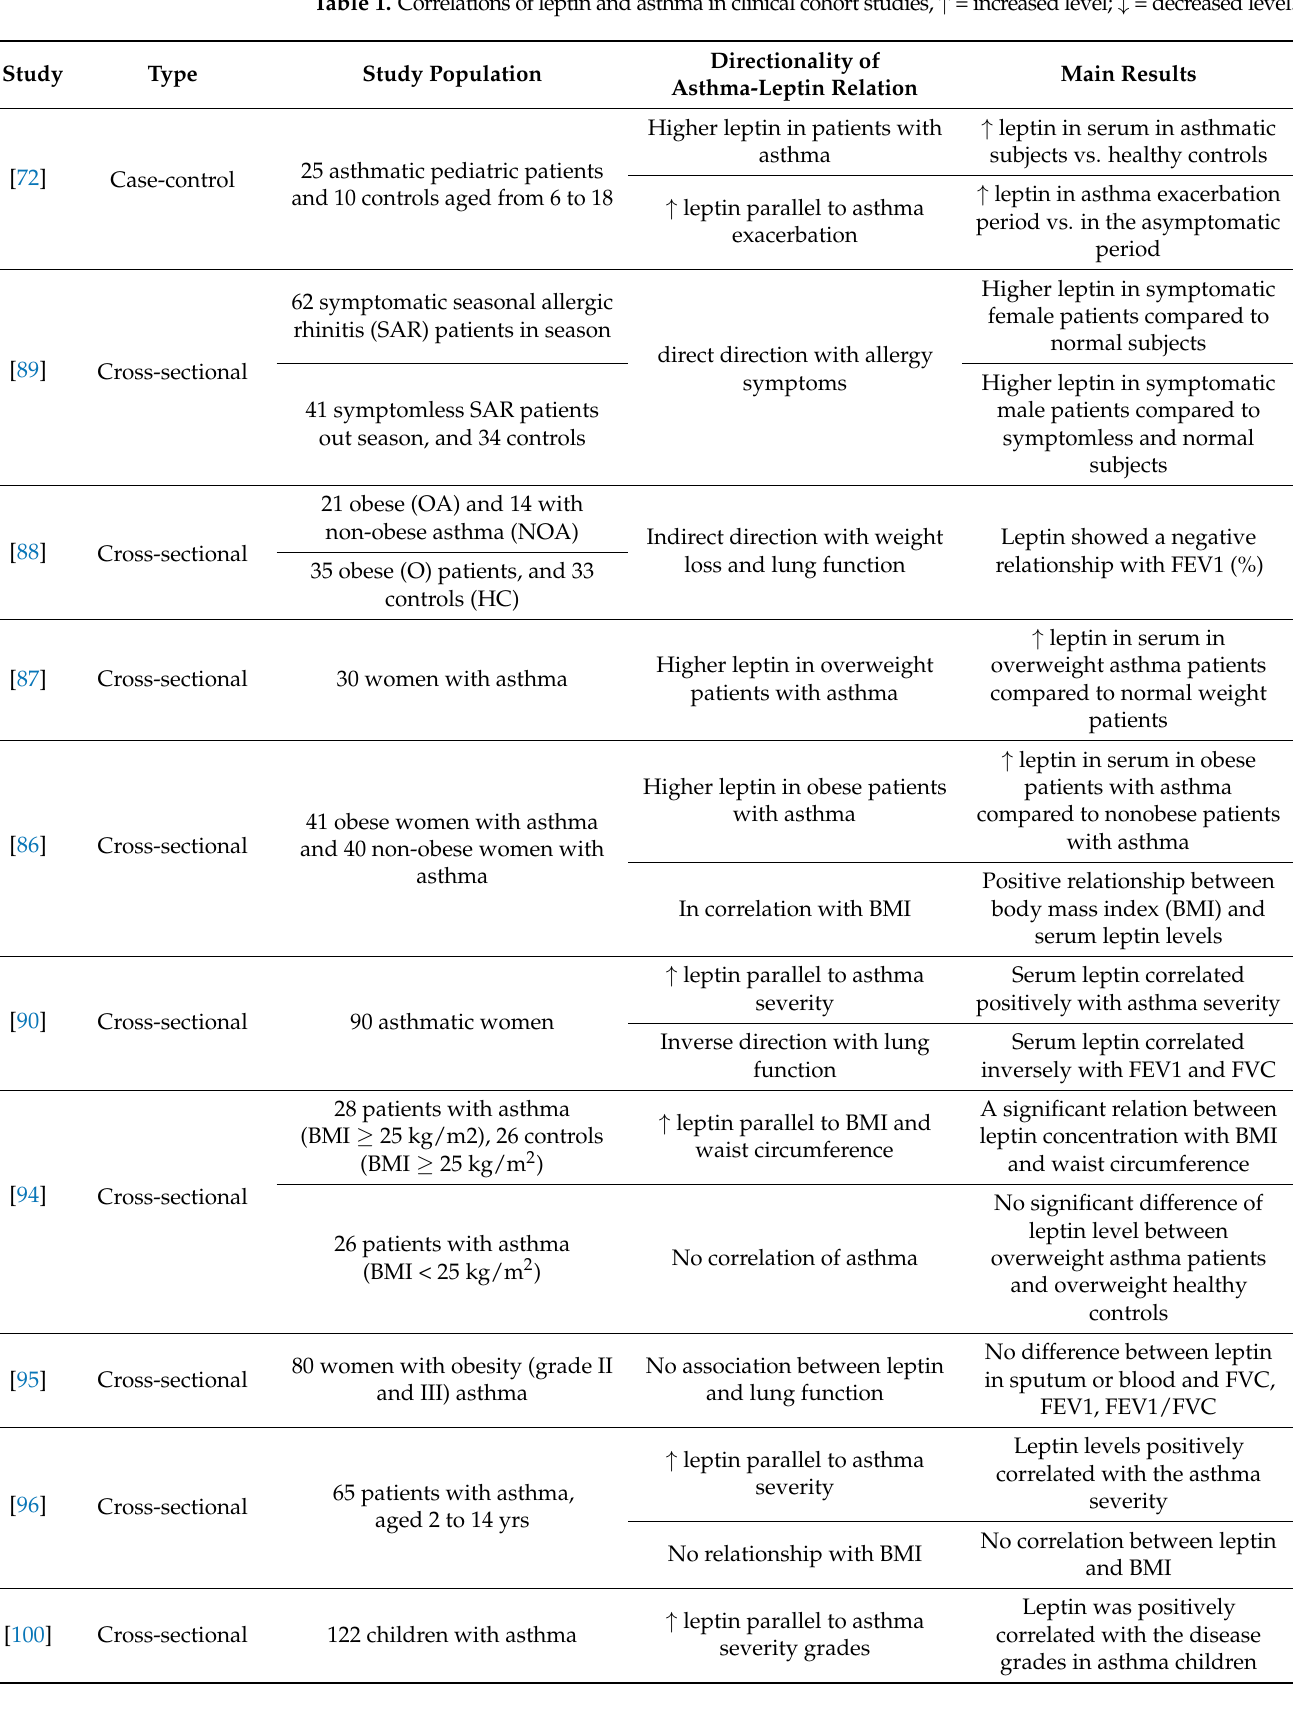
Table 1. Correlations of leptin and asthma in clinical cohort studies, ↑ = increased level; ↓ = decreased